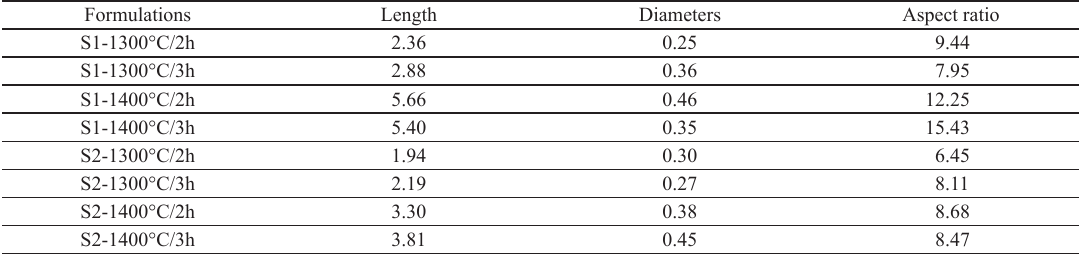
Table 4. Physicomechanical properties of formulations S1 and S2.